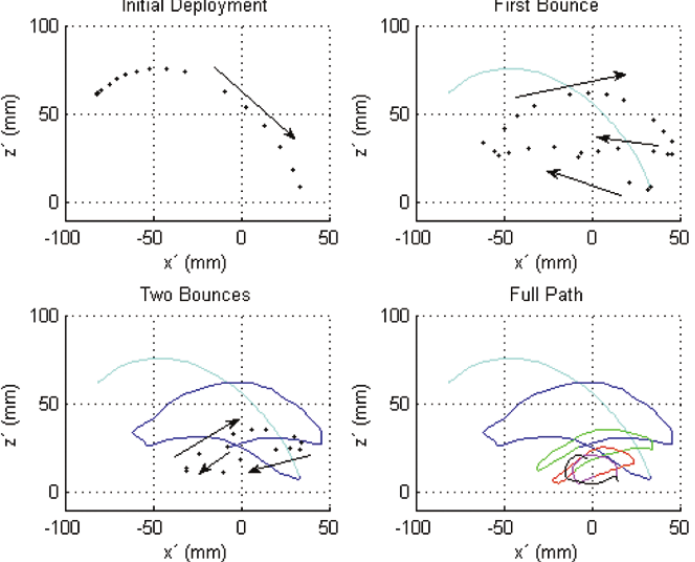
Fig. 7. The path data for a typical deployment with high lateral momentum, separated by bounces, is shown in the flattened cylindrical coordinates. Subsection 3.2, the six dof will then be reduced to a parsimonious coordinate system ( x ′ ,z ′ ) based on the manifold of poses during unforced